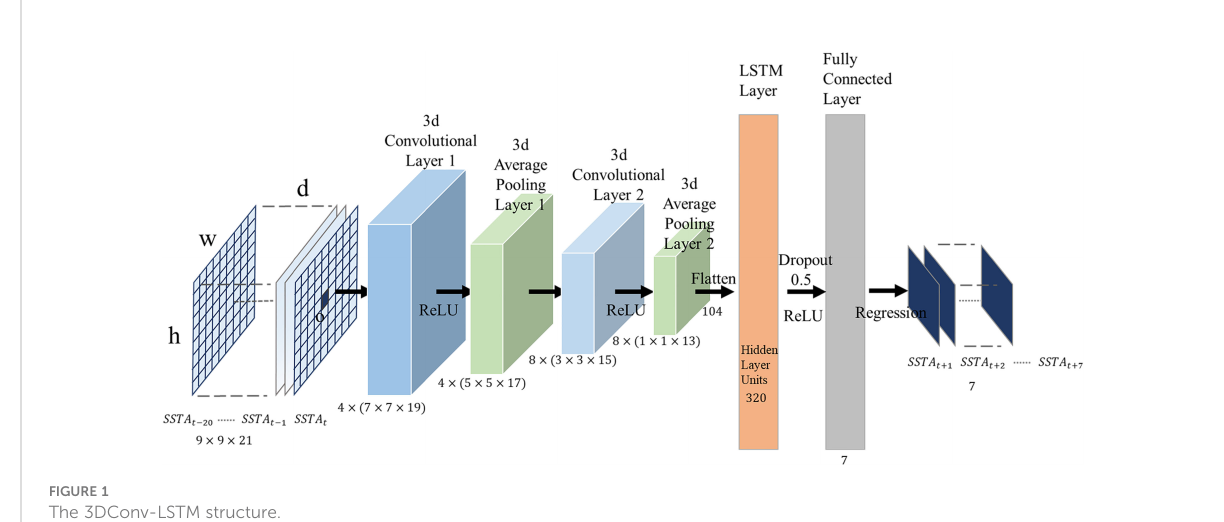
FIGURE 1 The 3DConv-LSTM